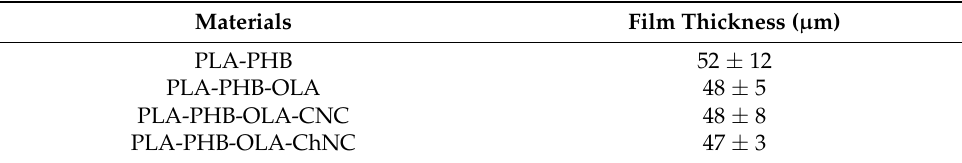
Table 2. The thickness of blown films produced from the compounded materials.